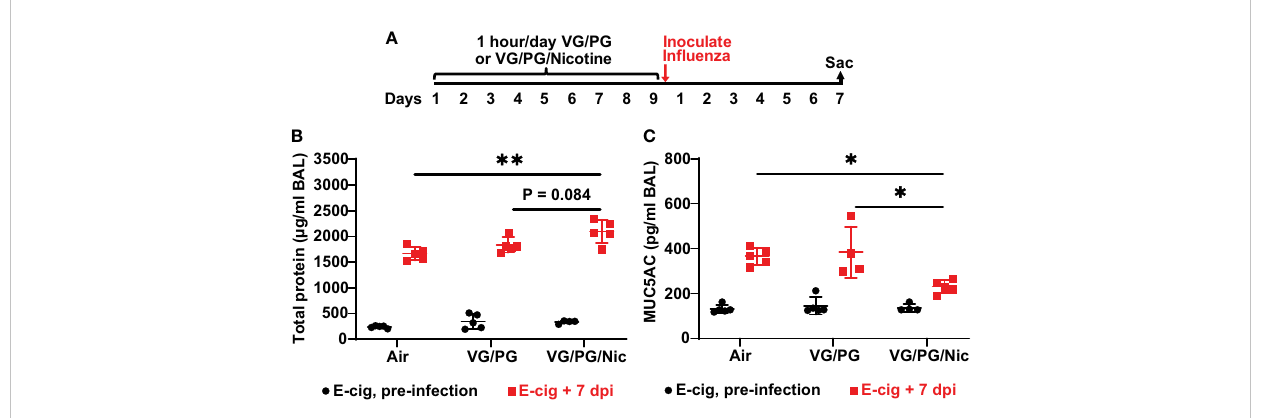
FIGURE 3 Aerosolized nicotine increases the lung barrier permeability to protein and blunts the increase of MUC5AC in the airspaces induced by in fl uenza infection. (A) Timeline of the experiment. After nine days of e-cigarette aerosol exposure, mice were intranasally inoculated with 300 foci-forming units of in fl uenza A H1N1 PR8 strain and then sacri fi ced 7 days post inoculation (dpi) to perform BAL. (B) Total protein concentration, presented in microgram/milliliter (µg/ml), in the BAL was not signi fi cantly different between groups after e-cigarette exposure before in fl uenza infection. BAL protein signi fi cantly increased (p < 0.05) after in fl uenza infection and was signi fi cantly higher at 7 dpi in the mice that were exposed to nicotine- containing aerosol (VG/PG/Nic) than those exposed to air. (C) Mucin 5 subtype AC (MUC5AC) concentration, presented in picogram/milliliter (pg/ml), in the BAL was not signi fi cantly different between groups after e-cigarette exposure before infection. BAL MUC5AC was signi fi cantly increased (p < 0.05) by in fl uenza infection at 7 dpi but to a lesser degree in mice exposed to aerosolized VG/PG/Nic which was signi fi cantly lower compared to mice exposed to the aerosolized carrier VG/PG or to air. * P < 0.05, ** P < 0.01, 1-way ANOVA with Tukey ’ s multiple comparisons test between the three groups at 7 dpi. Each data point represents one